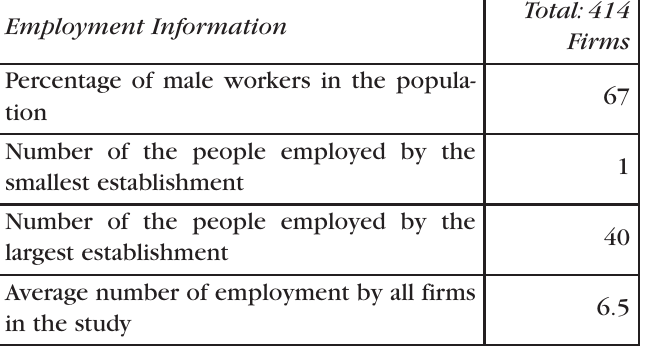
Table 1. Composition of Employees